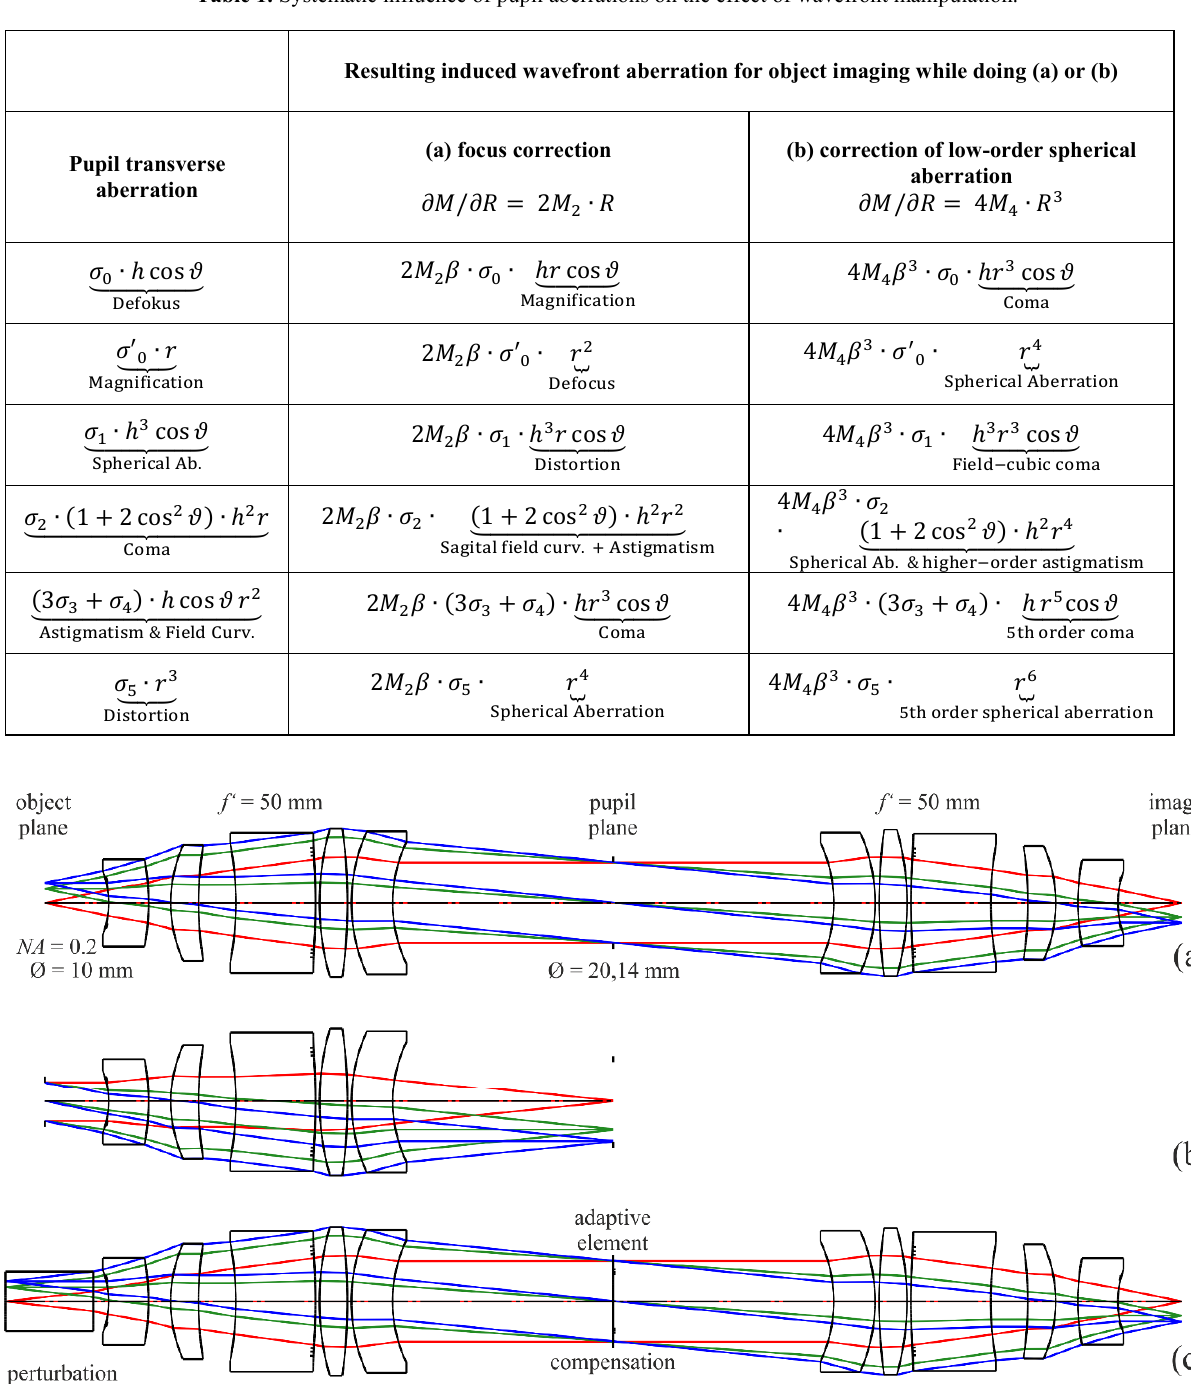
Table 1. Systematic influence of pupil aberrations on the effect of wavefront manipulation.